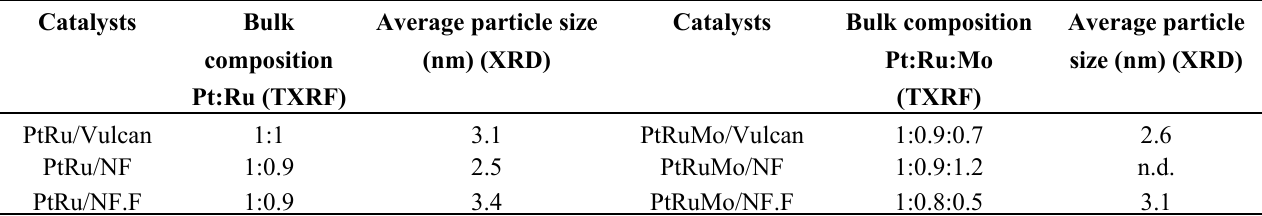
Table 3. Effect of support. Structural parameters of the